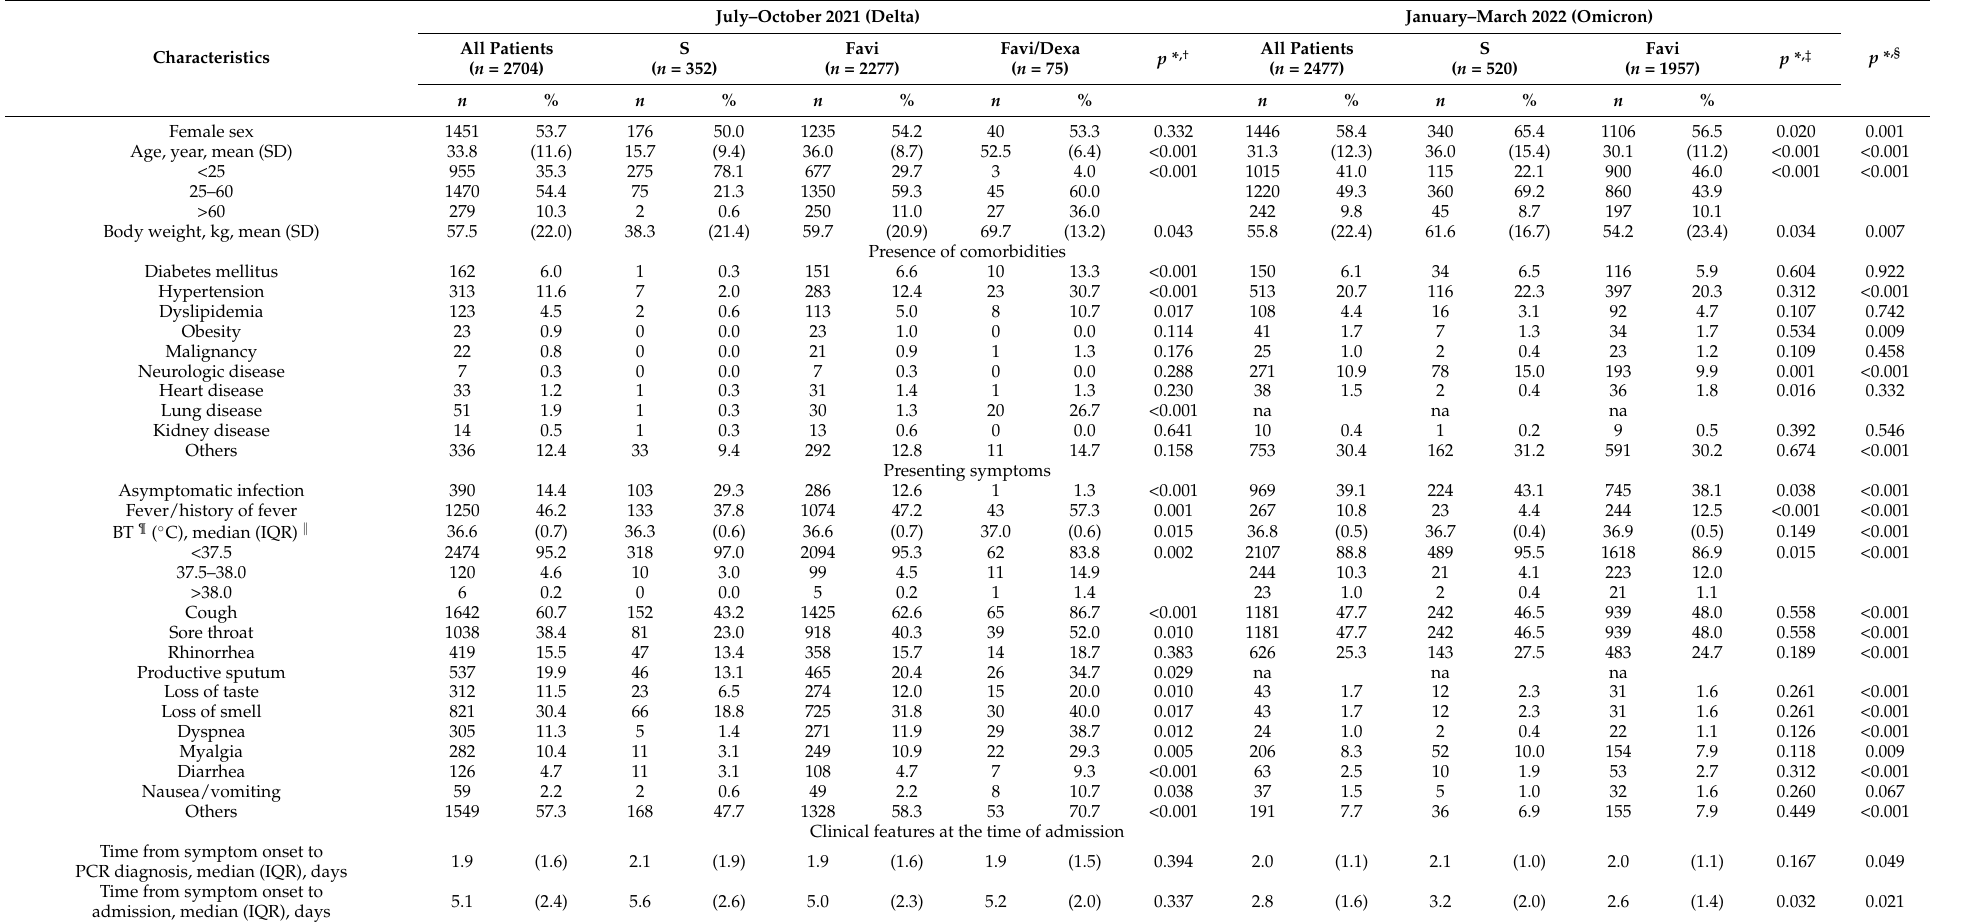
Table 1. Characteristics and laboratory findings of all confirmed COVID-19 patients, compared between those with symptomatic treatment (S), symptomatic treatment plus 5–14 days’ standard favipiravir treatment (Favi) and symptomatic treatment plus 5–14 days’ standard favipiravir treatment plus dexamethasone treatment (Favi/Dexa)